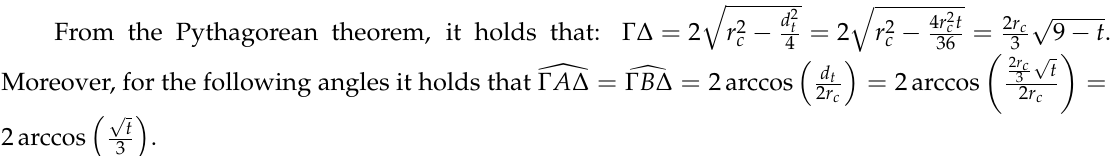
Figure A1. B current position of random walker and A random walker’s position before t